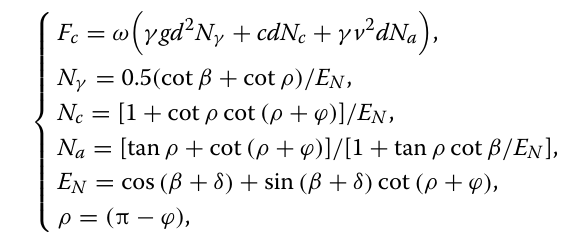
Figure 4 Resistive force analysis of the digging